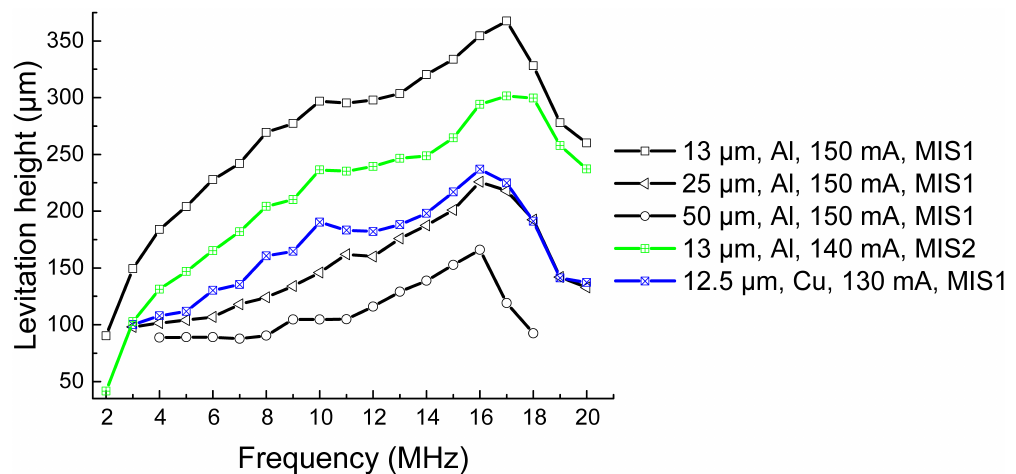
Figure 4. Levitation height as a function of input current